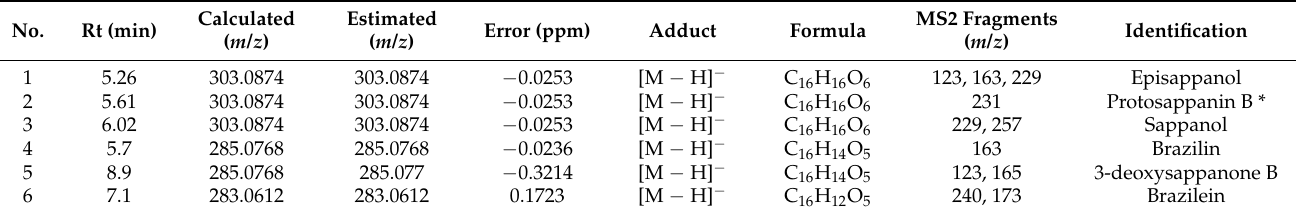
Figure 1. UPLC-MS/MS analysis of CSLW. ( A ) Total ion chromatogram in negative ion mode of CSLW. ( B ) Extracted ion chromatograms of CSLW. 1, Episappanol; 2, Protosappanin B; 3, Sappanol; 4, Brazilin; 5, 3-deoxysappanone B; 6, Brazilein. Identified compound 2 was compared with the mass spectrum and retention time of the reference standards. Table 1. Constituents identified in CSLW by